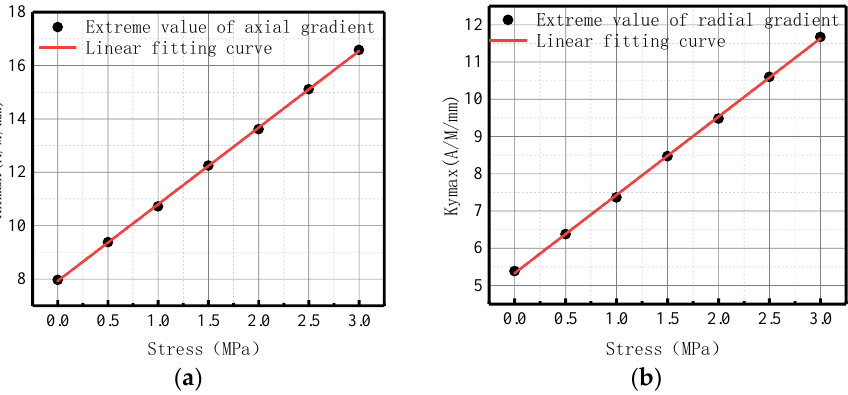
Figure 10. Kmax variation with internal pressure. ( a ) Axial component of Kmax ; ( b ) radial component of Kmax .